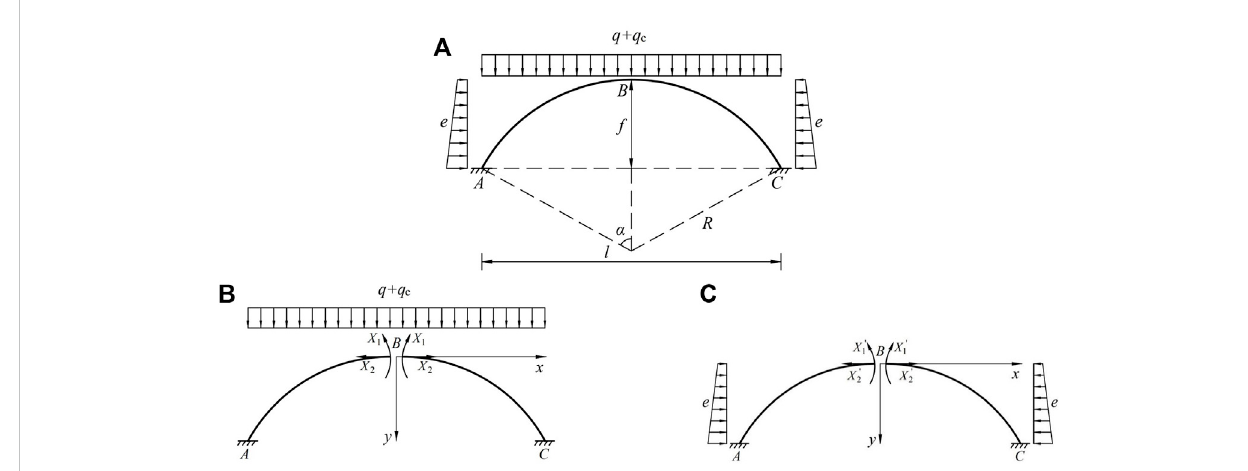
FIGURE 4 Internal force analysis model of covered arch: (A) Action of all loads; (B) Vertical load action; (C) Horizontal load